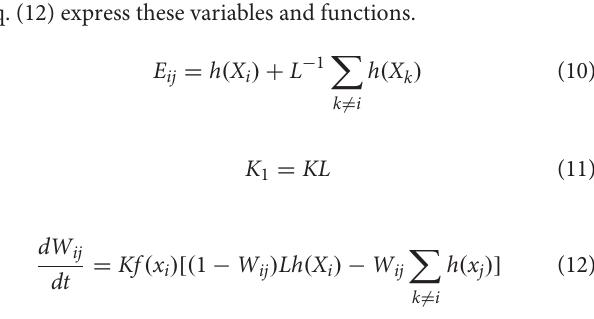
Eq. (12) express these variables and functions.